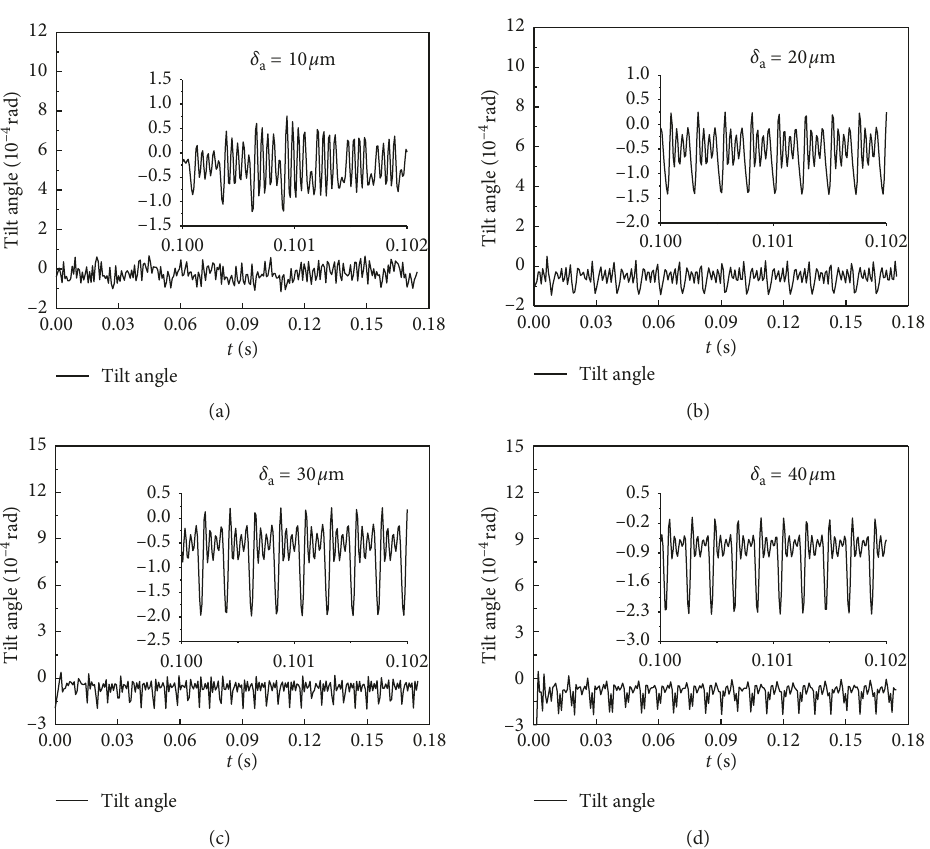
Figure 10: The tilt angle of the conical roller. F